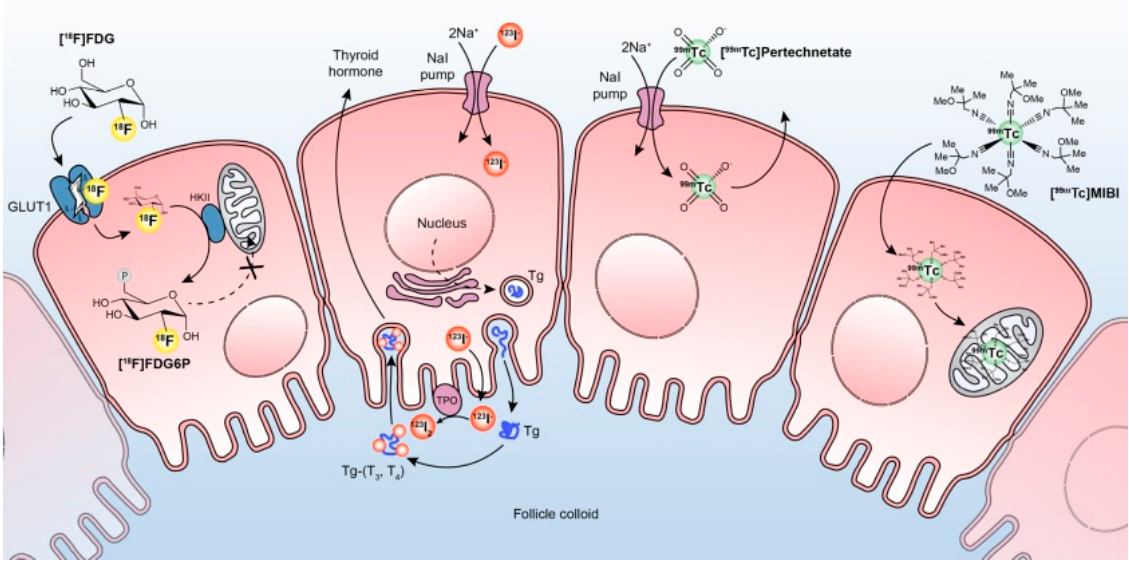
Figure 1. The different metabolic pathways in radioisotope imaging of thyroid nodules. 18 F FDG is transported into the follicular cell by the transmembrane glucose transporter GLUT1. The intracellular 18 F FDG is then phosphorylated by HKII to 18 F FDG6P, which traps the compound and prevents its efflux. In malignant cells, both the expression of GLUT1 transporters and the activity of hexokinase may be increased. Thyroid follicular cells trap 123 I using the sodium-iodine symporter, which concentrates iodine intracellular and incorporates the 123 I into thyroglobulin (Tg). The 123 I is oxidized by thyroid peroxides’, at the follicular cell colloid interface, to neutral iodine, which binds to tyrosine residues on Tg to form thyroid hormones (T3 and T4) stored in the colloid follicular lumen. A similar mechanism is encountered for other iodine radiotracers like 124 I and 131 I. 99m TcO 4 − is trapped by the thyroid follicular cells in an identical manner as 123 I, but is neither organified nor incorporated into thyroid hormones and then is not retained in the thyroid. 99m Tc MIBI is a lipophilic monovalent cationic agent that crosses the cell membrane and concentrates in the mitochondria due to its positive electric potential. Adapted from Rager O et al. Gland Surg 2019 [6]. Copyright ID: 1187094-1, Nancy International Ltd. Subsidiary AME Publishing